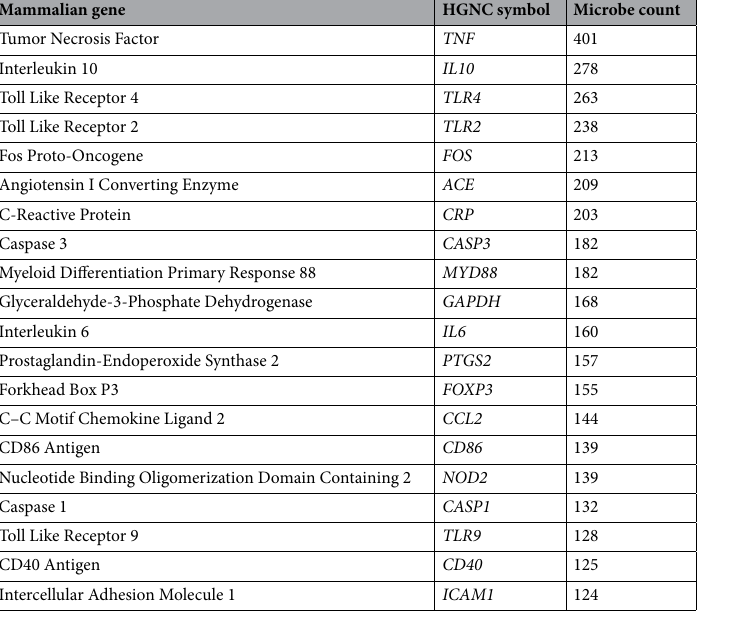
Table 1. Mammalian genes with most microbe-gene associations from PubMed